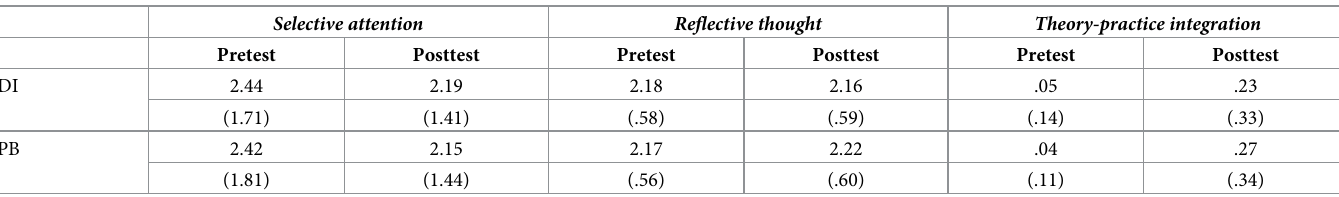
Table 3. Means (and standard deviations) of the three dependent